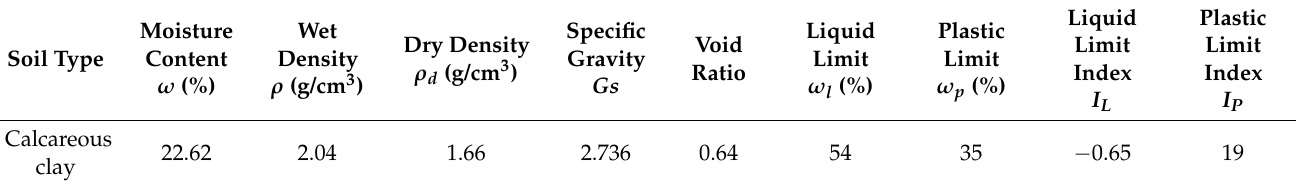
Table 1. Basic physical parameters of calcareous clay.